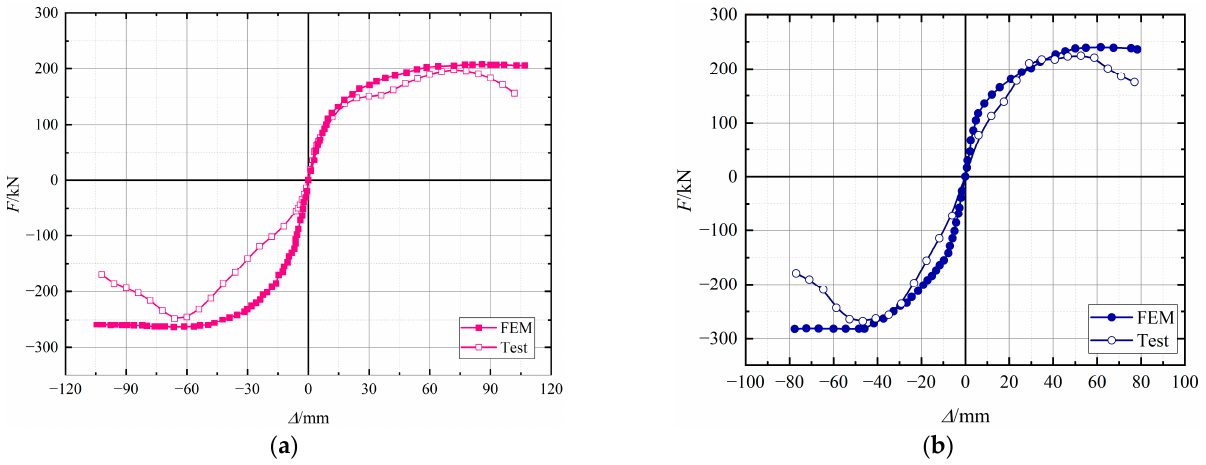
Figure 19. Comparison of the skeleton curves: ( a ) WP-1; ( b ) WP-2.